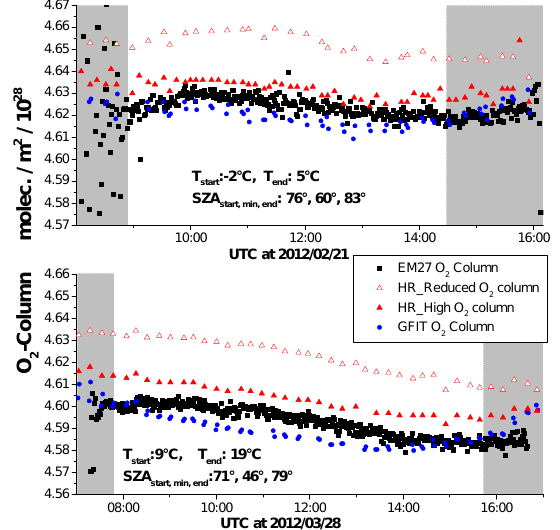
Fig. 7. CO 2 columns for 2 days. The systematic offsets of the 4 datasets is very similar to those in the O 2 -columns. The num- ber of interferograms and respective recording interval contained in a single datapoint of each type are the same than in Fig. 6 The shaded areas filter out SZAs beyond 70 ◦ and measure- ments taken within the first 30 min after the start of measure- ments. We added the latter restriction as the EM27 requires some startup time before it operates in a stable manner. Af- ter moving it from the 20 ◦ C lab environment to the outside − 12 ◦ C, the HeNe reference laser tube temporarily